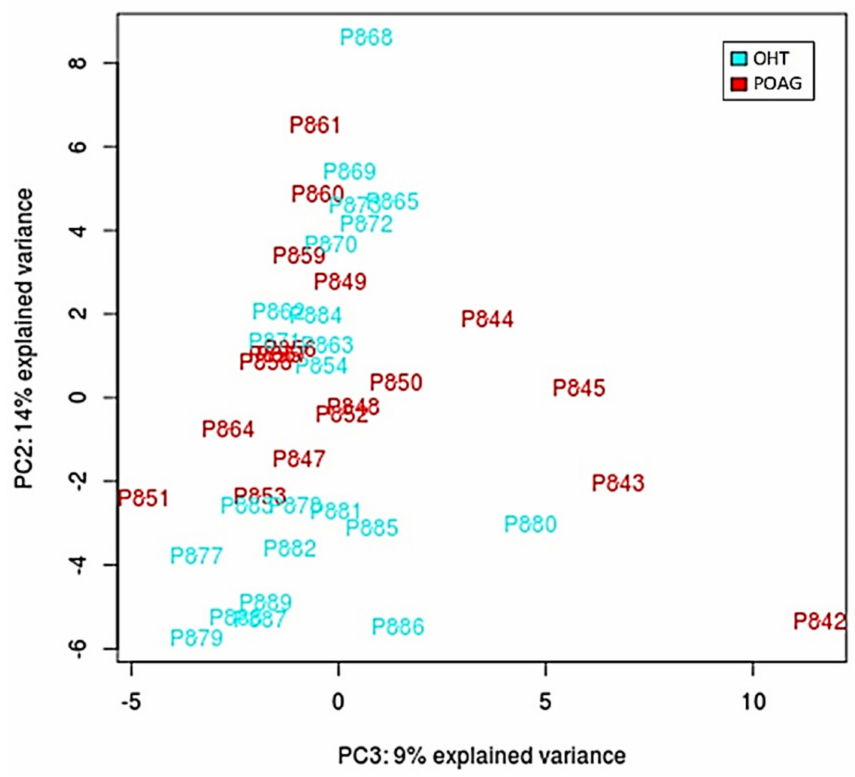
Figure 1. Principal component analysis (PCA) plot after normalization of the data according to the eight differentially expressed miRNAs. Image shows ocular hypertension/ocular hypertension patients (blue marks) and primary open-angle glaucoma (red marks) patients.